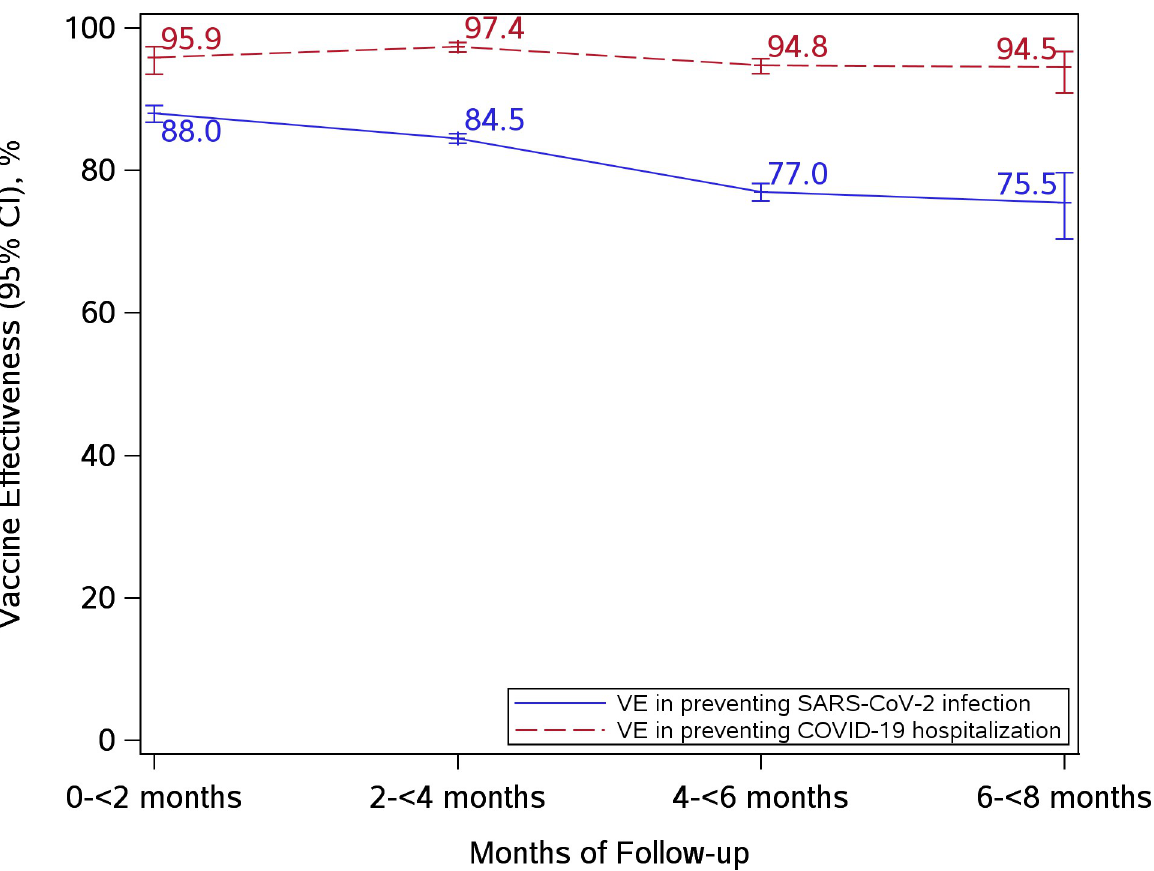
Fig 3. Vaccine effectiveness of 2 doses of mRNA-1273 in preventing SARS-CoV-2 infection and COVID-19 hospitalization by months after vaccination.